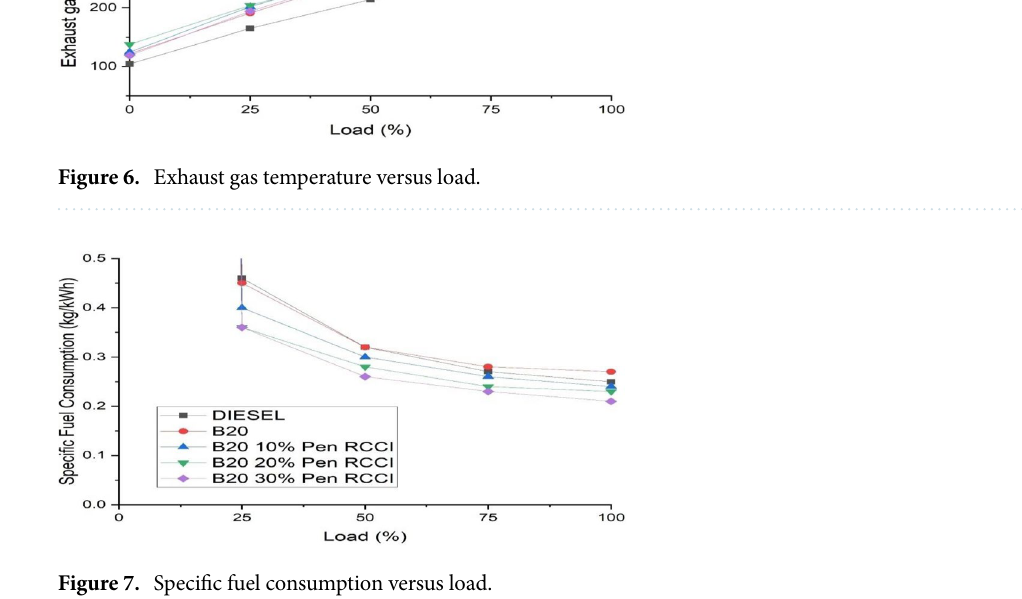
Figure 7. Specific fuel consumption versus